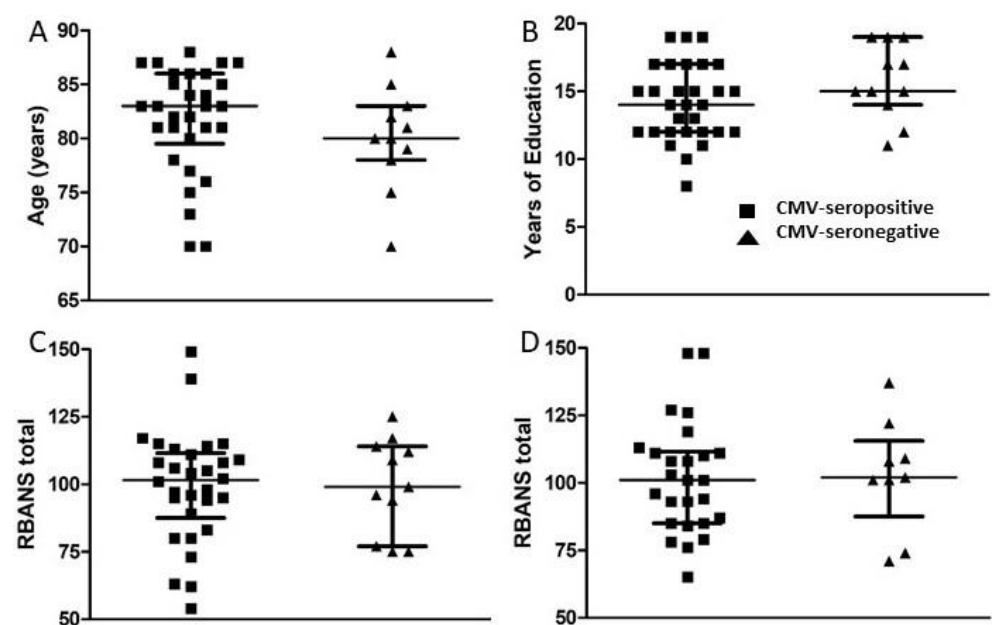
Figure 3. Comparison of age, years of education, and RBANS total scores between groups of CMV-seropositive and CMV-seronegative subjects. ( A ) Age and ( B ) years of education are represented as at study entry (t1) for all subjects. Following neuropsychological testing, RBANS total scores were calculated at t1 for all study subjects ( C ) and approximately 18 months later (t2) for all study subjects completing follow-up ( D ). Error bars on graphs show median ± interquartile range for each group. No significant differences between CMV-seropositive and -seronegative groups were observed. Mann–Whitney U -test, ( A ) p = 0.215, ( B ) p = 0.128, ( C ) p = 0.883, ( D ) p = 0.895.